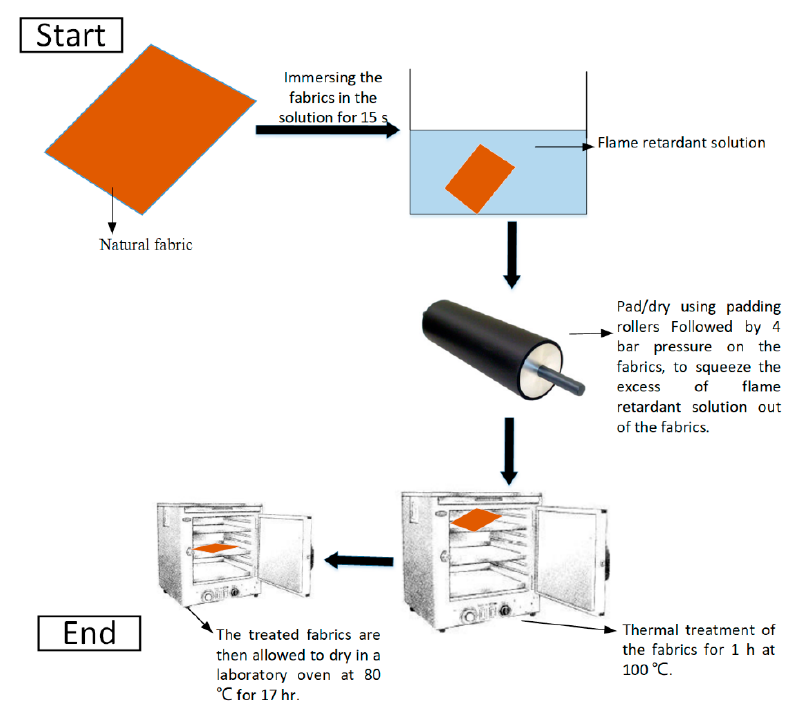
Figure 3. Schematic illustration of fibre treatment.